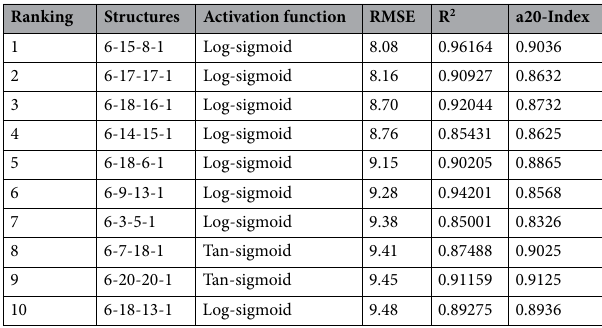
Table 7. Ranking of BPNN models based on RMSE (top